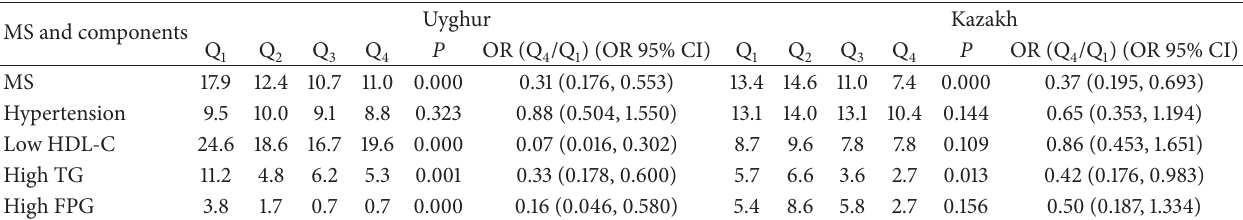
Table 6: Detection rates of MS and components in each adiponectin level quartile.